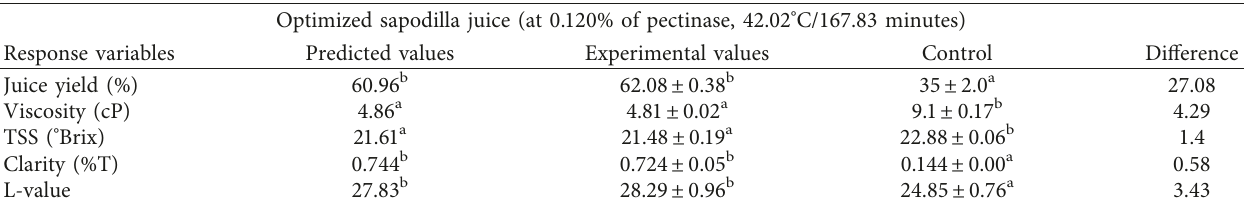
Table 5: Experimental validation of predicted responses and comparison with control juice (at optimal